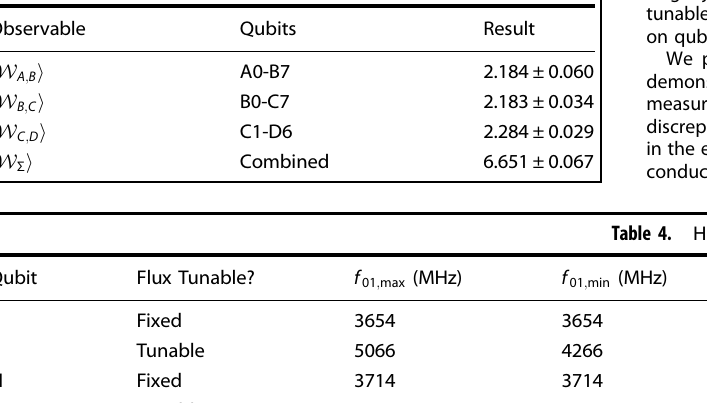
Table 3. Results for joint Bell test marginals and total